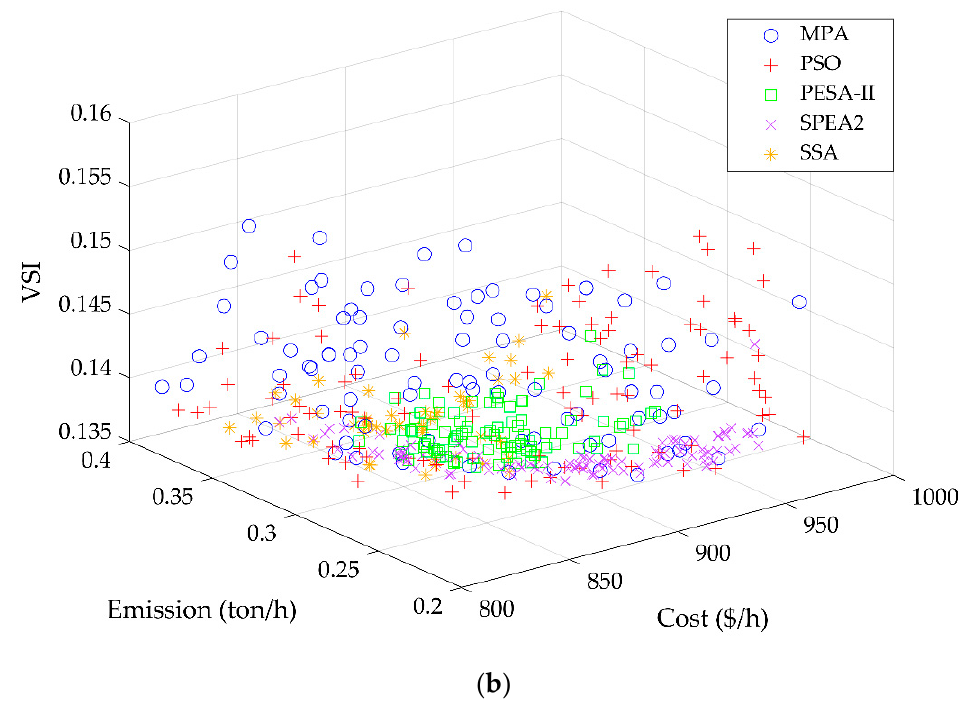
Figure 5. Three-dimensional Pareto fronts for: ( a ) case 13; ( b ) case 14.